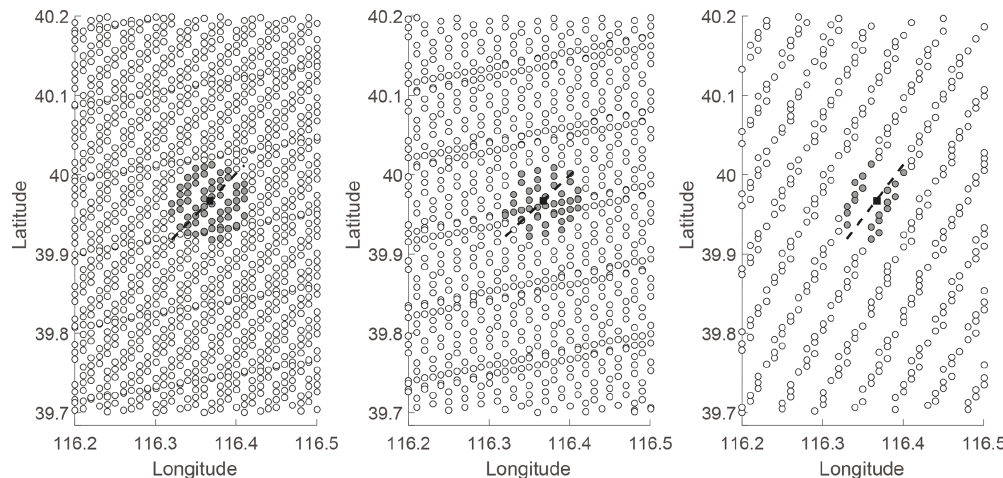
Figure 3. Locations of the Terra MODIS CTHs (circles) and the Ka radar (solid black squares). The three panels exhibit three spatial resolutions of MODIS CTH data due to the changing viewing geometry of the individual satellite overpass. Solid grey circles are MODIS pixels within 5km of the IAP site. The possible path scanned by Ka radar is demonstrated by a dashed black line.